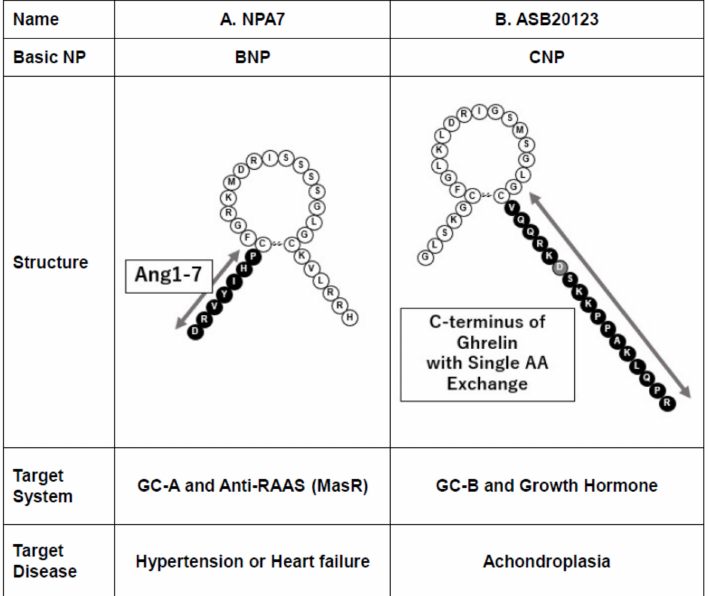
Figure 3. Designer NPs: Combination of NP and peptide from other systems. AA, amino acid; Ang1–7, angiotensin1–7, GC-A, guanylyl cyclase-A, GC-B, guanylyl cyclase-B; MasR, Mas receptor; RAAS, renin-angiotensin-aldosterone